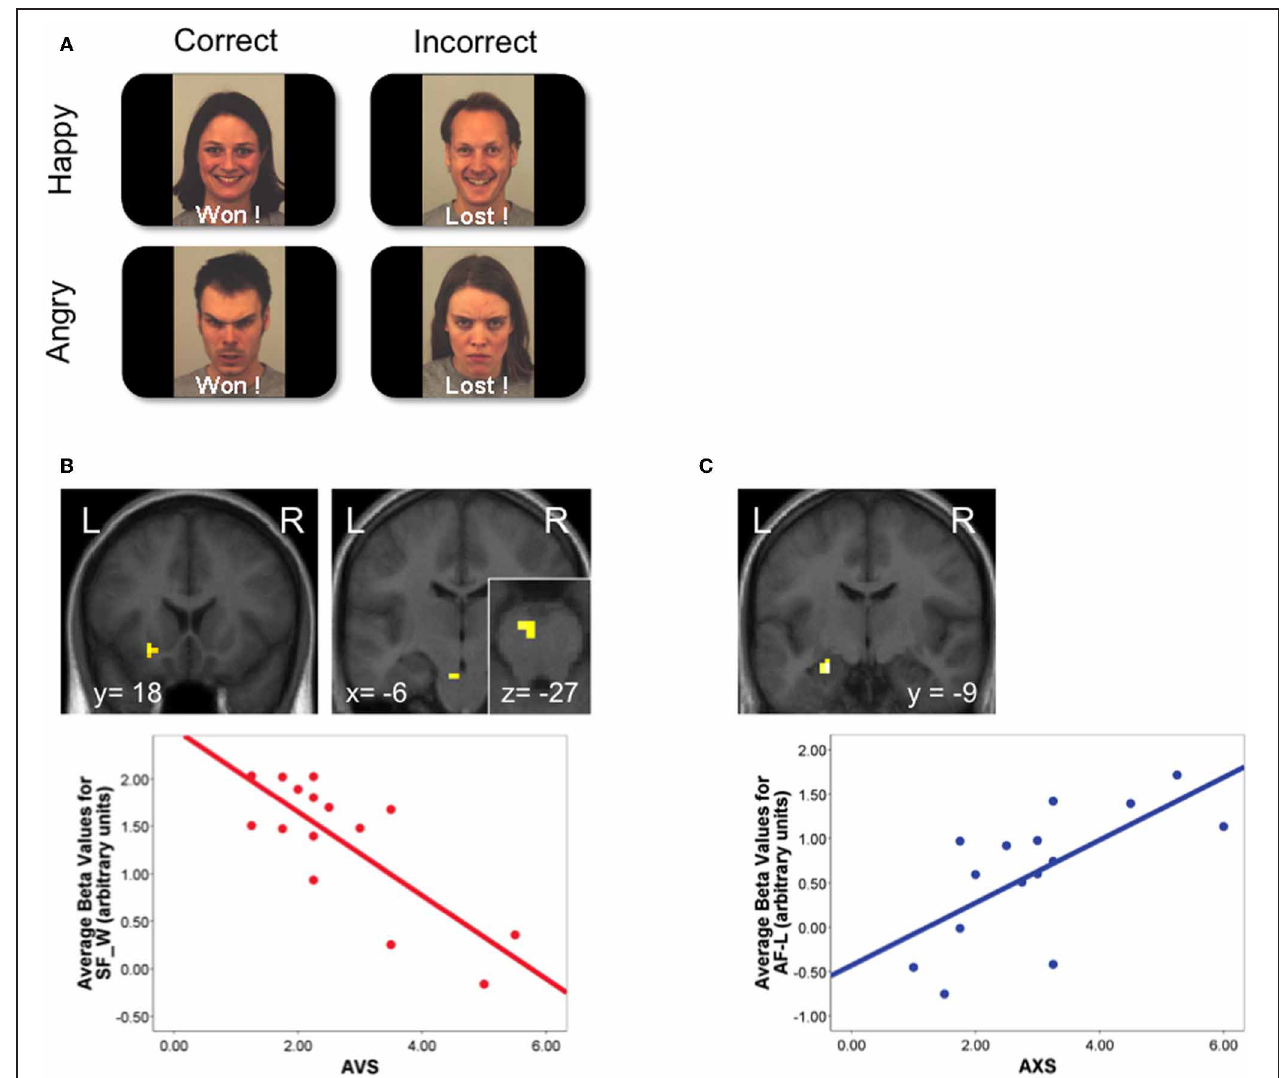
perception of positive social feedback (“Won” paired with a smiling face; SF-W), but this effect was modulated by avoidant attachment style. Bottom: negative relation between avoidant attachment style (AVS) scores and the ventral striatum response. (C) Top: the central amygdala was activated by the perception of social punishment (“Lost” paired with an angry face; AF-L), and this effect was modulated by anxious attachment style. Bottom : positive relation between anxious attachment style (AXS) scores and amygdala response. BOLD signal is depicted in arbitrary